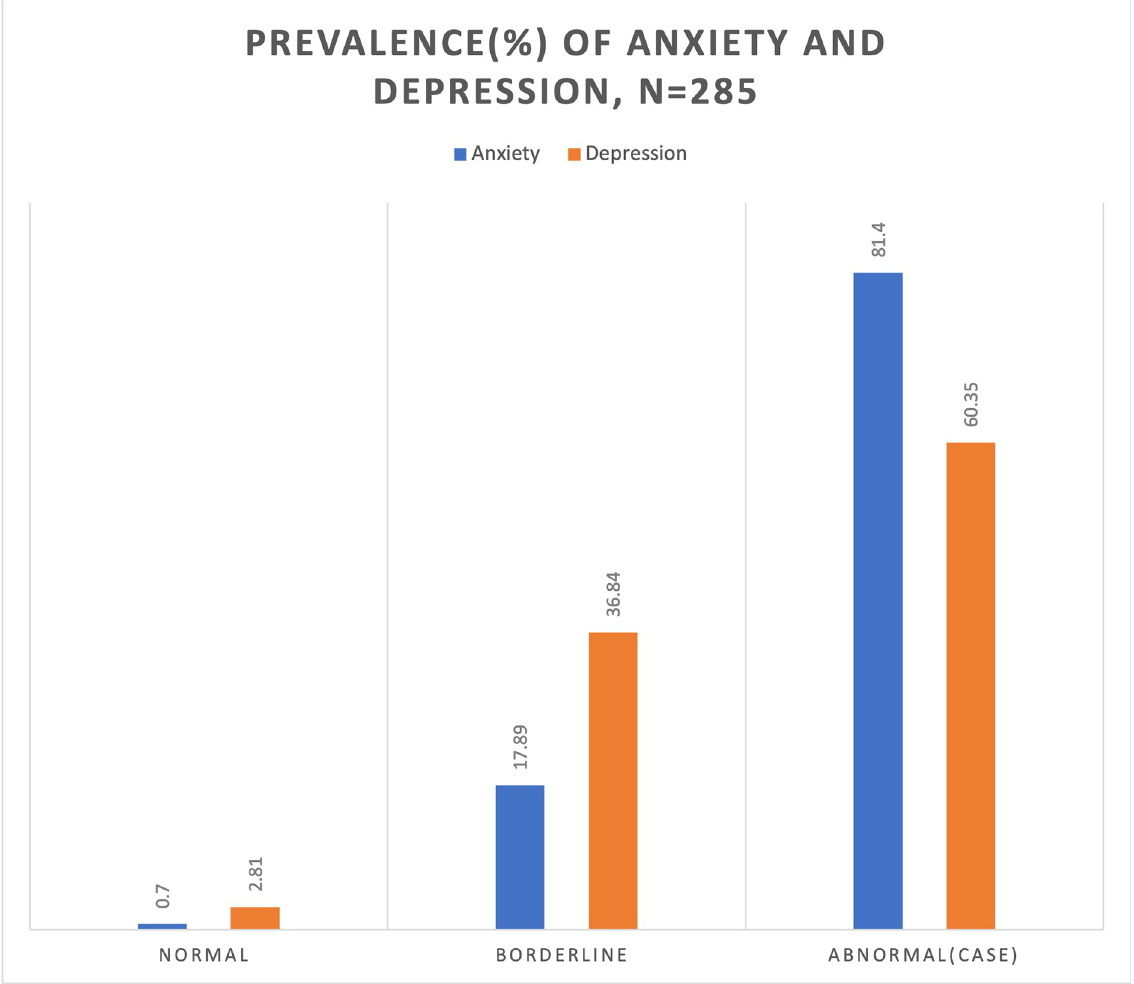
Fig 2. Prevalence of depression and anxiety among hospitalised COVID-19